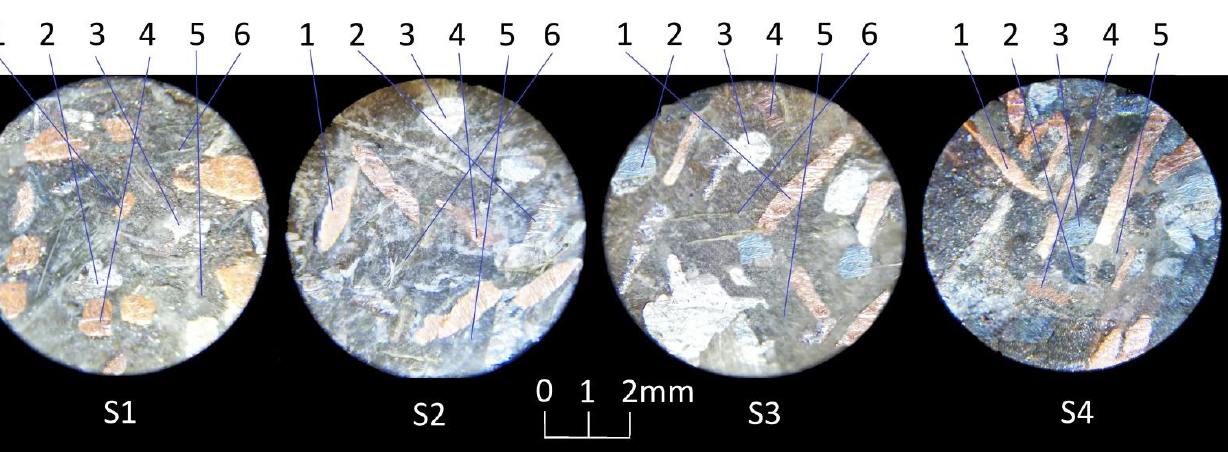
Figure 3. Micrograph of the surface of samples from each group: 1 — copper, 2 — cast iron, 3 — steel, 4 — brass, 5 — matrix (resin with graphite and ash), 6 — aramid.